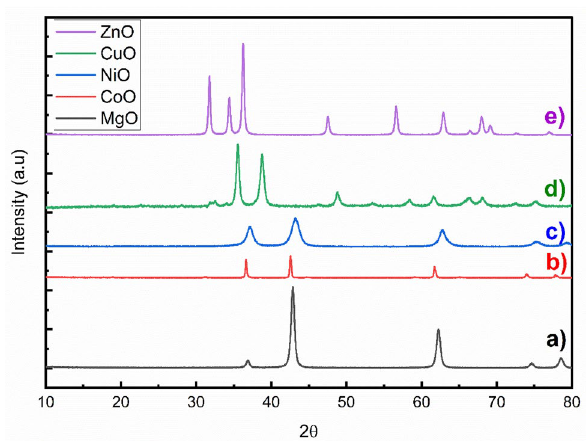
Fig. 3 TG–DTA plots of HEO powder precursors